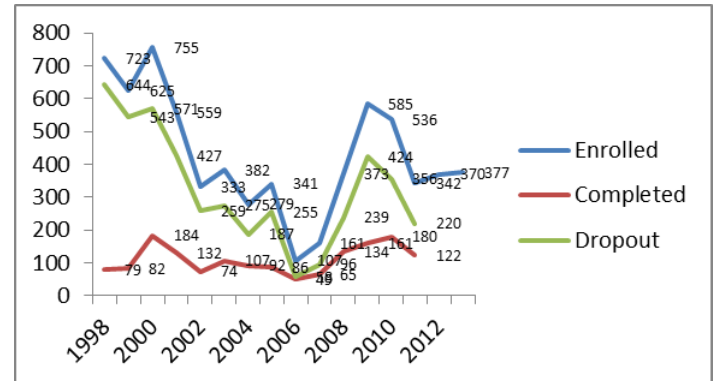
Figure 2: Enrollment, Dropout and Completion trends of DCSA Program [ Source: Secondary data from SSS and Examination divisions, BOU, March